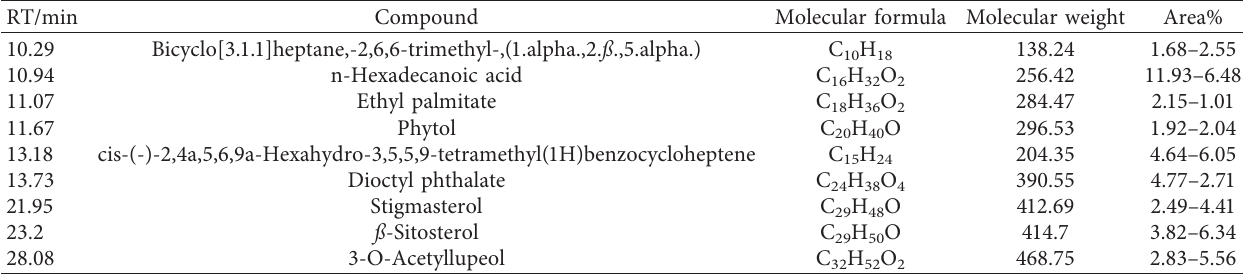
Table 4: Interpretation of GC-MS analysis: identified compounds that are contained in both ETH and EHX. RT/min Compound